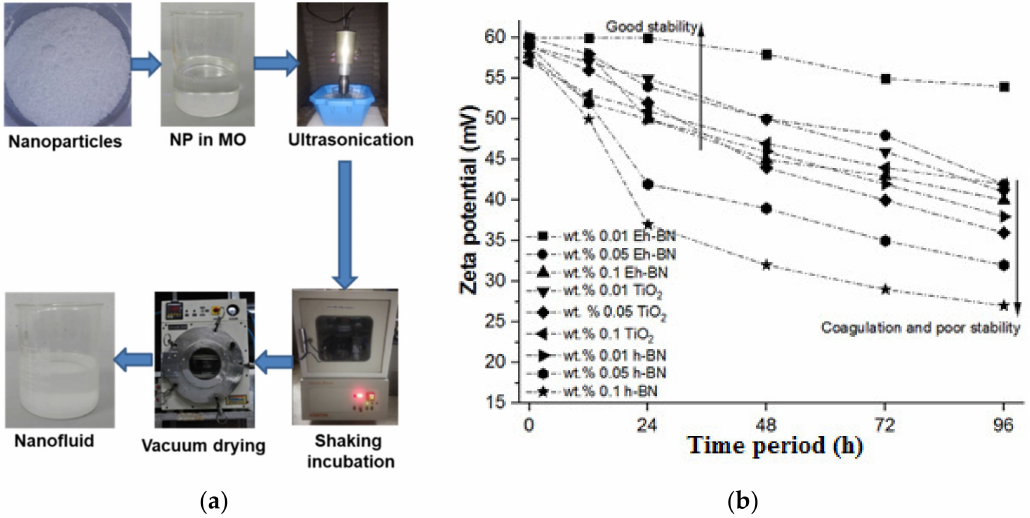
Figure 1. ( a ) Preparation of nanofluids; ( b ) stability of NFs at different concentrations of